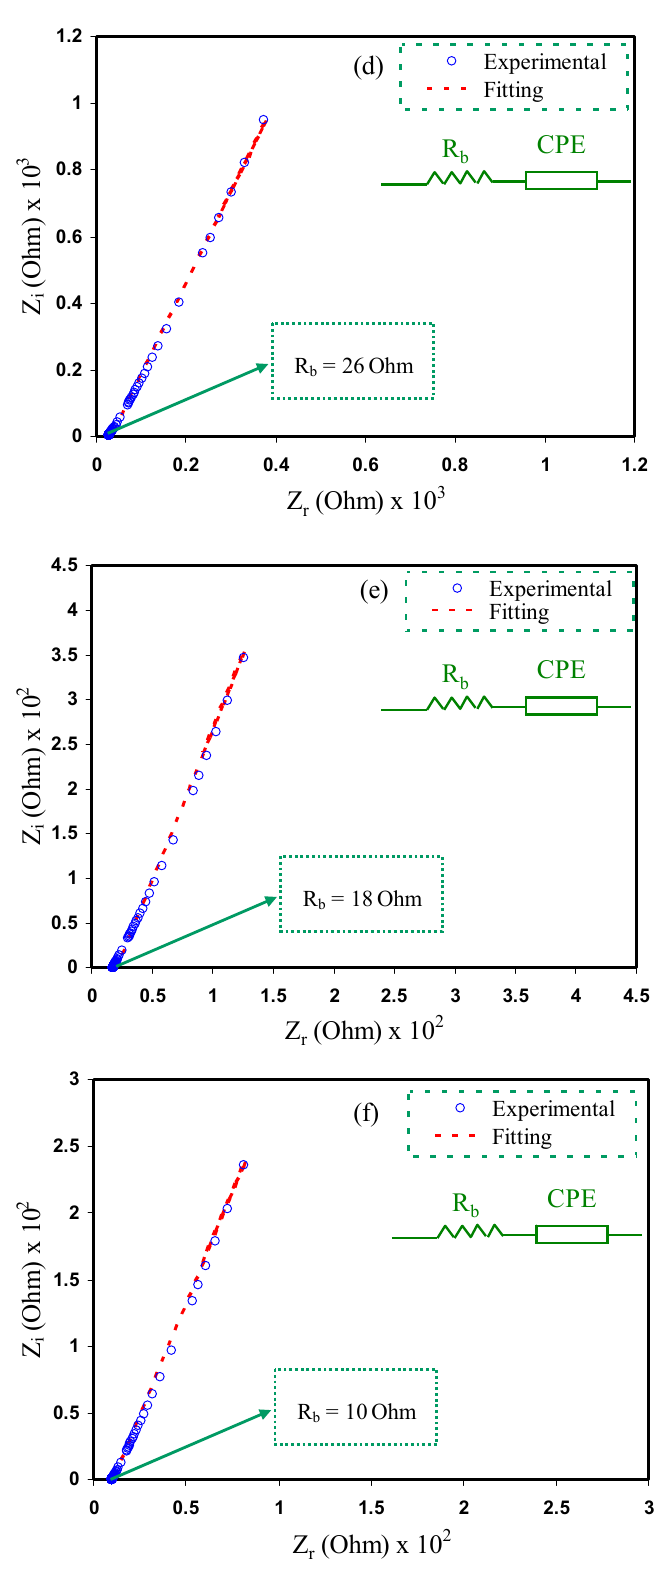
Figure 2. Impedance plots for ( a ) CSNHG0, ( b ) CSNHG1, ( c ) CSNHG2, ( d ) CSNHG3, ( e ) CSNHG4 and ( f ) CSNHG5.